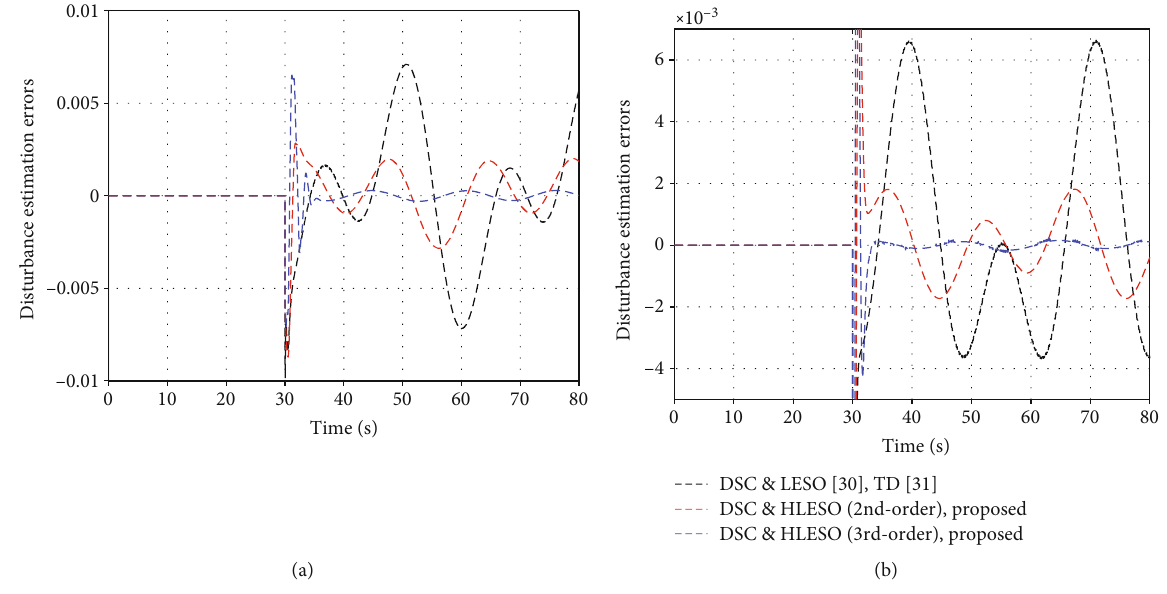
Figure 5: Disturbance estimation errors: (a) velocity channel and (b) altitude channel.